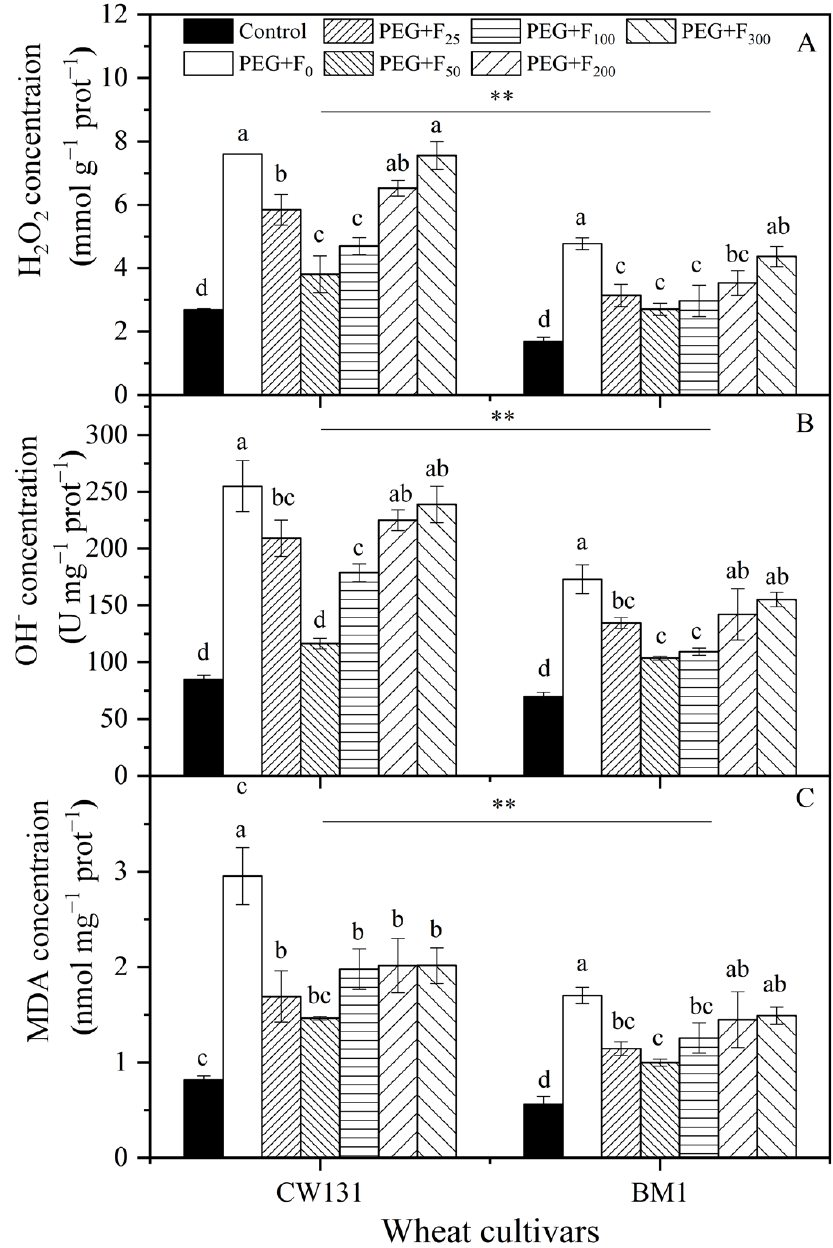
Figure 3. Changes in contents of hydrogen peroxide (H 2 O 2 ) ( A ), hydroxyl radical (OH) ( B ), and malondialdehyde (MDA) ( C ) of two wheat cultivars (CW131 and BM1) under different fullerol additions (concentrations range from 0 to 300 mg L − 1 ) and PEG (20% polyethylene glycol) treatment. Mean values ± SE are shown ( n = 3). Bars with different letters for the same cultivar imply a significant difference at p < 0.05. For ANOVA results, **, p < 0.01. Similarly, we fitted quadratic polynomial regression for the activities of SOD, CAT and POD in two winter cultivars (CW131 and BM1) plotted against six concentrations of fullerol (0, 20, 50, 100, 200, and 300 mg L − 1 ) (Figure S2) and found the same results (Tables